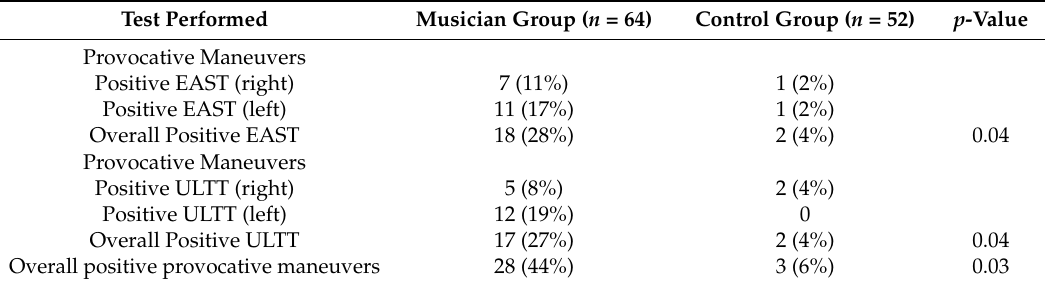
Table 3. Comparison of provocative maneuvers between the musician and control